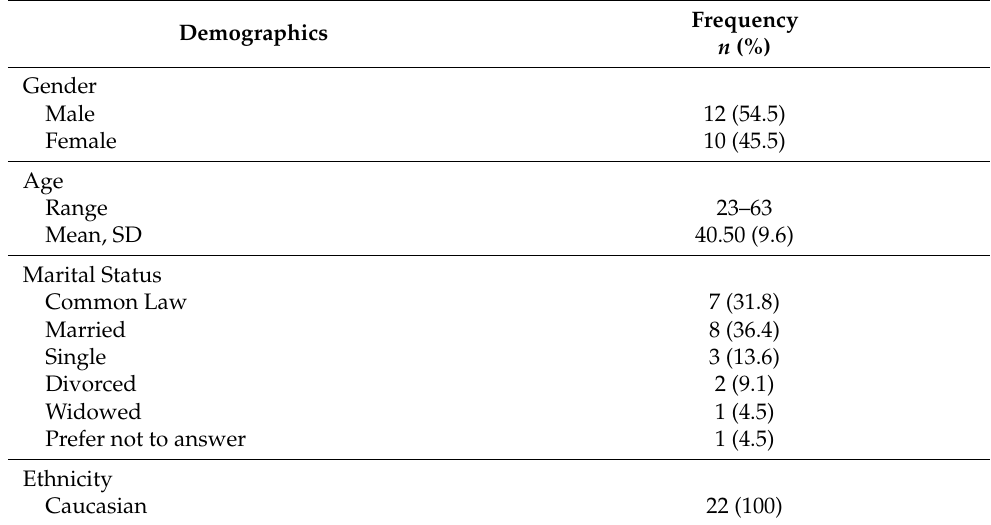
Table 4. Participant characteristics ( n =